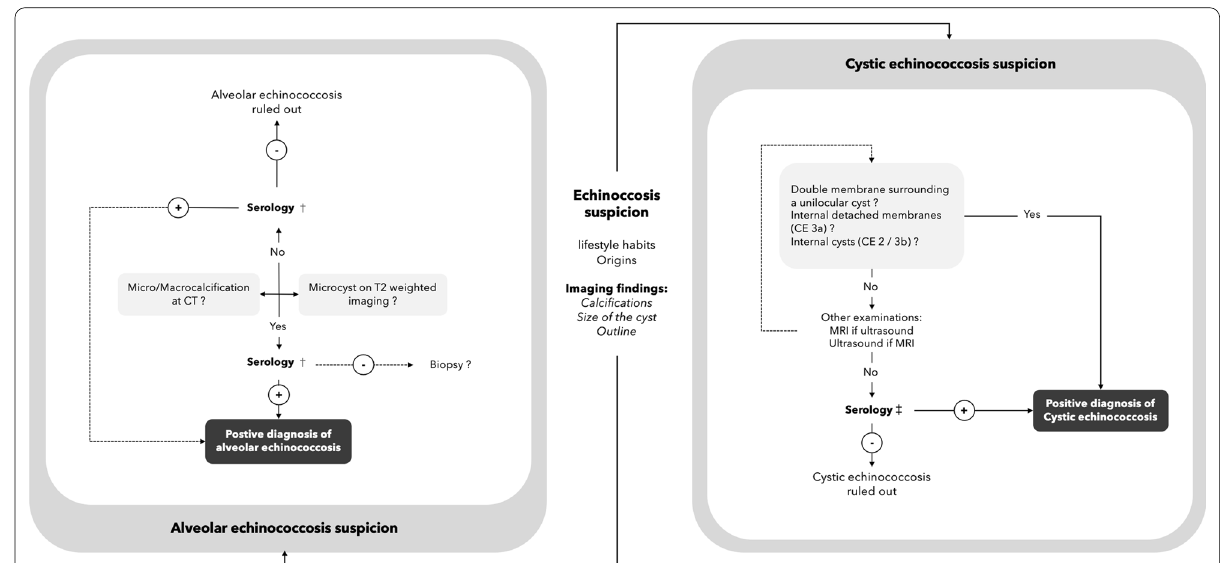
Fig. 2 Role of imaging in the positive diagnosis of CE and AE. †First‑line tests generally comprise EgHF‑ELISA or indirect hemagglutination. The confirmation test in combination with the Em2‑and rec‑Em18‑ELISA enables diagnosis with sensitivity of almost 100%. ‡ Western blotting is the more specific test, used as a confirmatory test in addition to ELISA and IHA (sensitivity varies according to CE